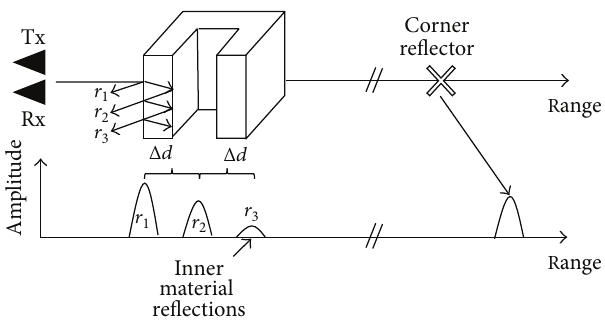
Figure 3: The ranging information is altered due to the different transmission media in the wall. Objects will appear further away.